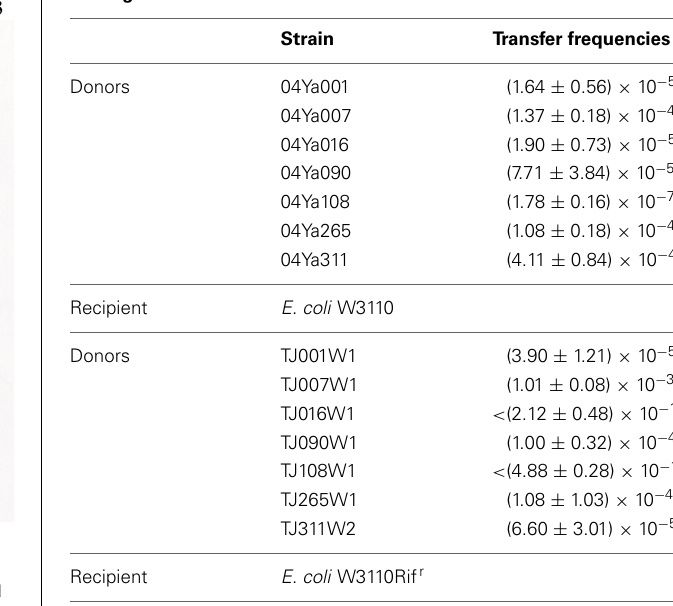
Table 4 | Transfer frequencies of tetracycline resistance by filter mating